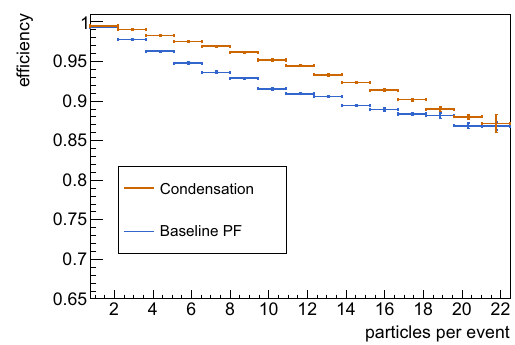
of additional interactions per bunch crossing (pileup).